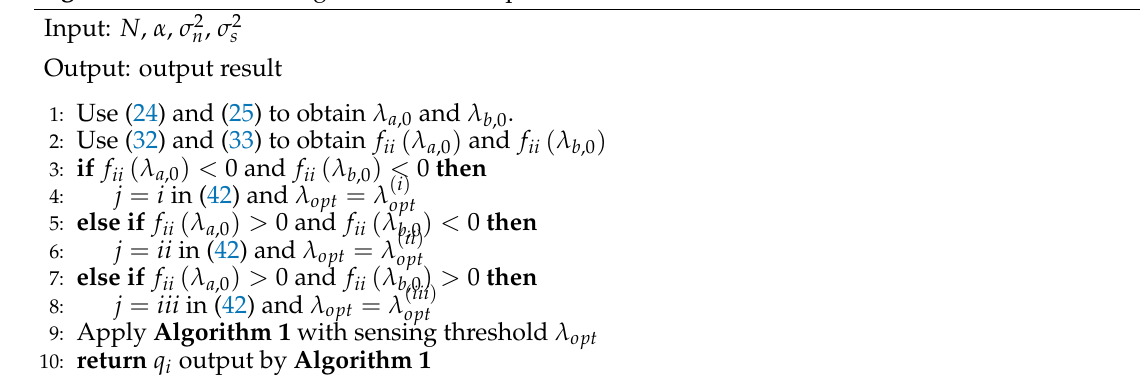
Algorithm 2 The 3EED algorithm with adaptive